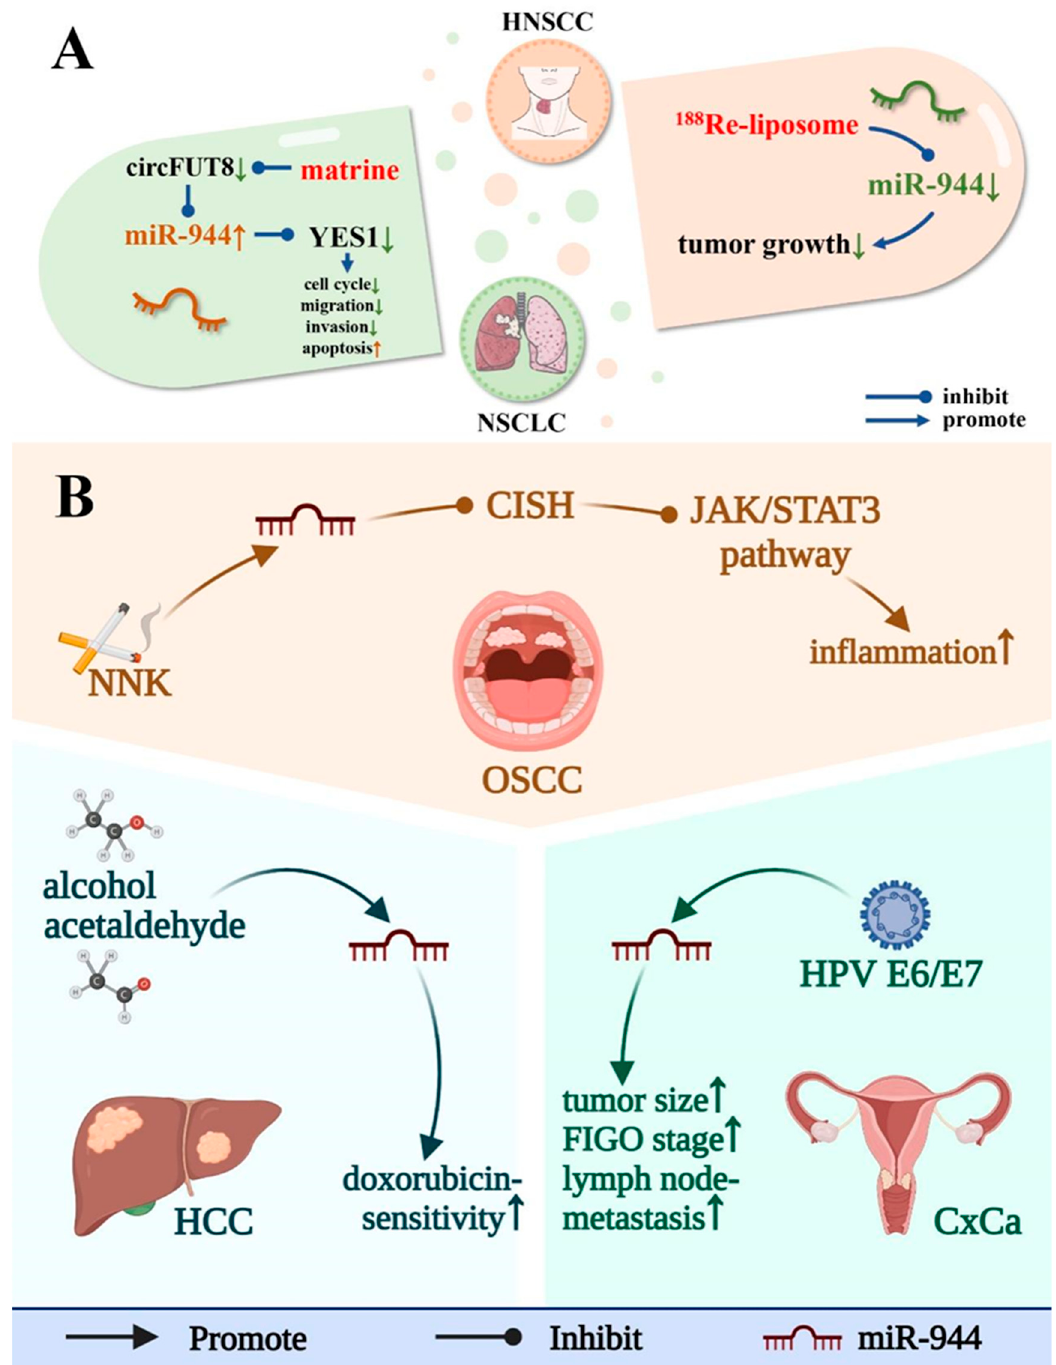
Figure 5. Exogenous factors and drugs affect the level of miR-944. ( A ) miR-944 is involved in the treatment of NSCLC and HNSCC by matrine and 188 Re-liposome, respectively; ( B ) exogenous factors (including NNK, HPV E6/E7, and alcohol and acetaldehyde) affect the expression level of miR-944 in the OSCC, CxCa, and HCC.